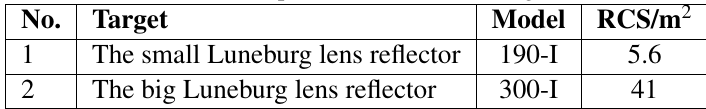
Table 1 The parameters of the test targets.